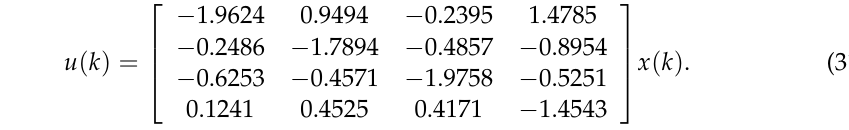
Fig. 6. Output-feedback closed-loop response to the impulsive distur- bance w ( k ) in Fig. 2 (top-left panel). Fig. 7.